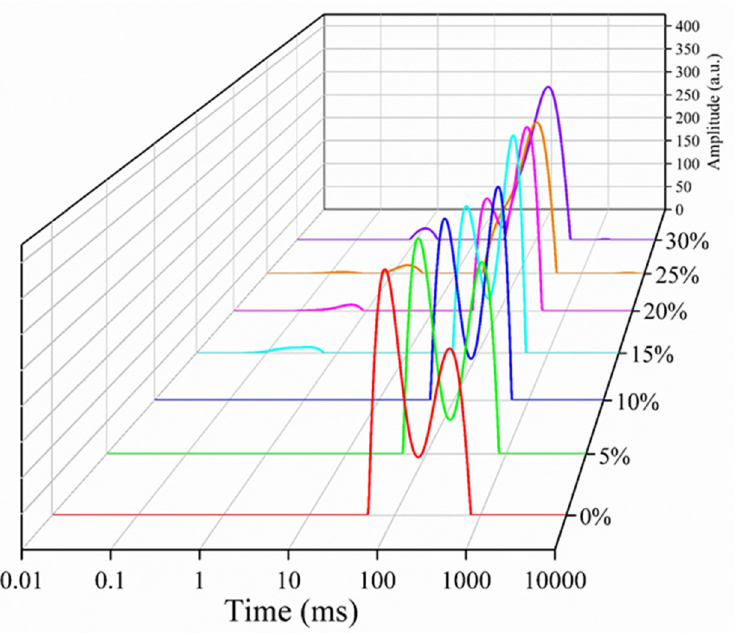
Figure 4. The distributions of T 2 relaxation times of the HIPEs with different levels of Antarctic krill oil (AKO) (0, 5, 10, 15, 20, 25, and 30%, w/w ) at 25 ◦ C. Table 3. The T 2 relaxation time and peak area of HIPEs with the oil phase (soybean oil) containing different levels of Antarctic krill oil (AKO) at 25 ◦ C. In each column, different letters denote significant difference ( p < 0.05). AKO Levels (%, w/w